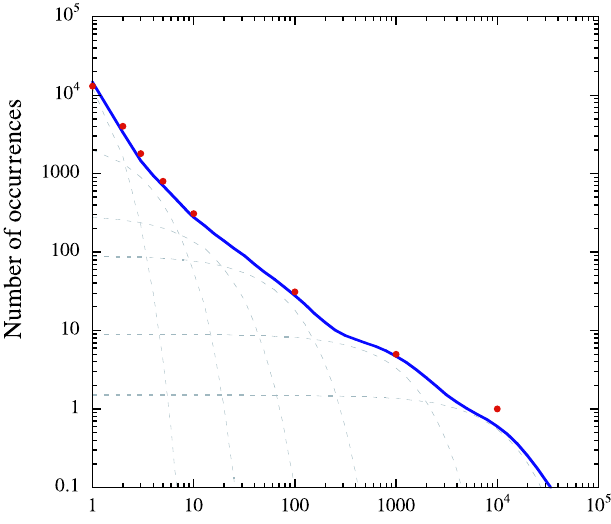
FIG. 14. (Color) The number of pulses between breakdown events at the same gradient, in the Fermilab linac, from Ref. [37]. The data (red dots) are compared with a curve (blue solid line) composed of the sum of exponentials (cid:2) e (cid:11) u i t with a , corresponding to differ- range of values of the time constant u i ent local strain levels ( gray, dashed lines).